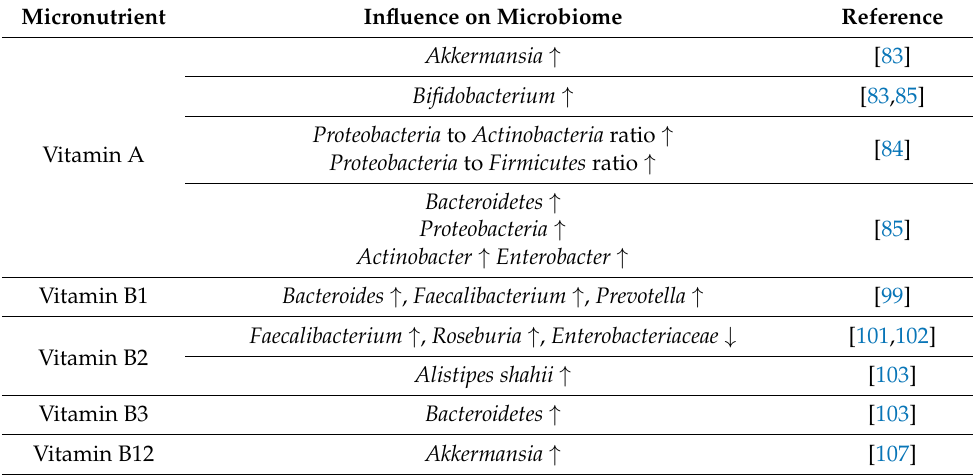
Table 2. The relationship between micronutrients and